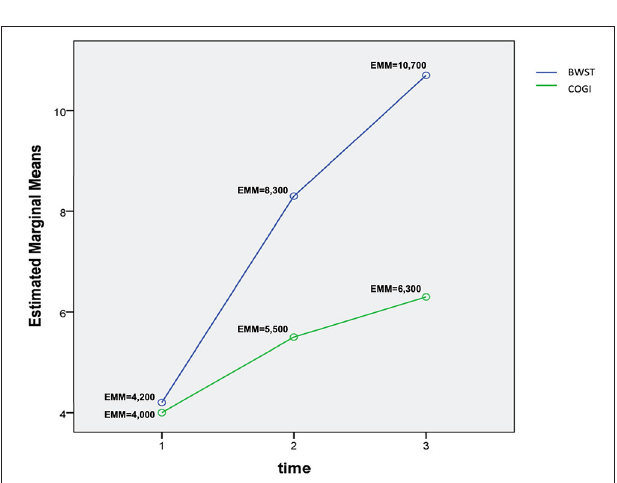
FIGURE 12 | Interaction plot describing the evolution of OFS means in T1, T2, and T3 between groups. OFS, Open Field Score; BWSTT, Body weight-supported treadmill training; COGI, Conventional overground intervention; EMM, Estimated marginal